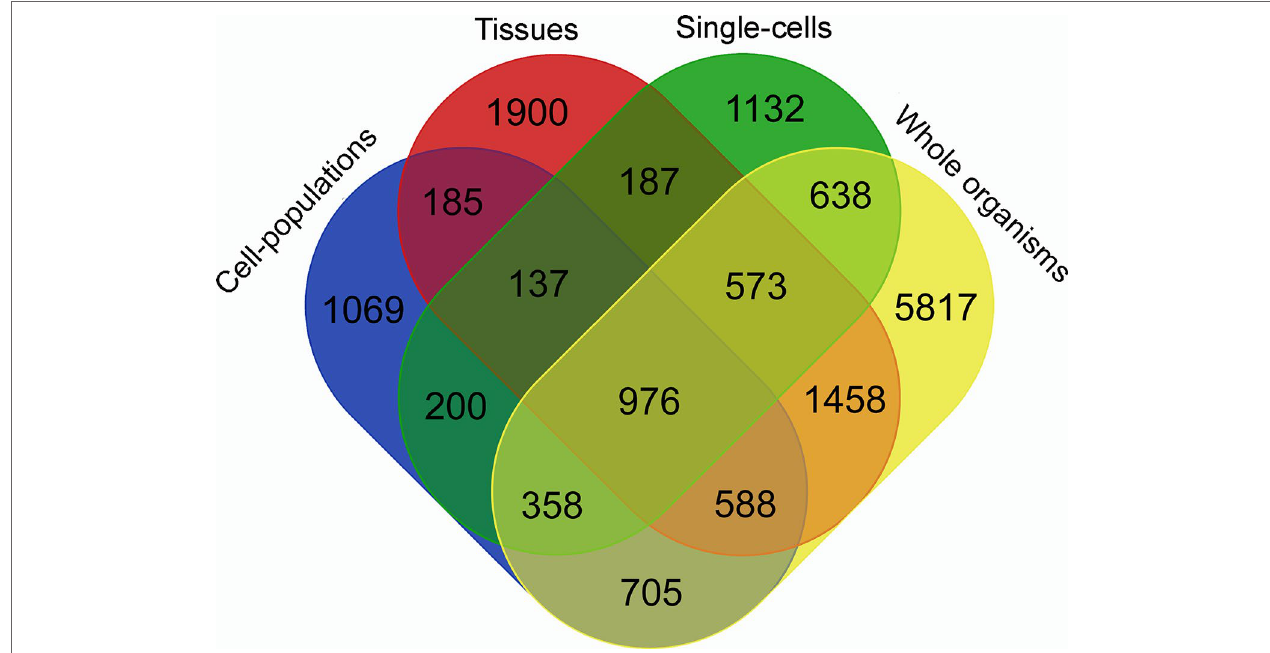
FIGURE 2 | Venn diagram representing the specific contribution from each type of RNA-Seq library to the S. mansoni lncRNAs set. TACO assembler was run separately for the RNA-Seq data from samples of four groups: whole organisms (yellow), tissues (red), cell-populations (blue) and single-cells (green), and each value indicates the number of transcripts that were reconstructed specifically with samples from groups indicated in each intersection.